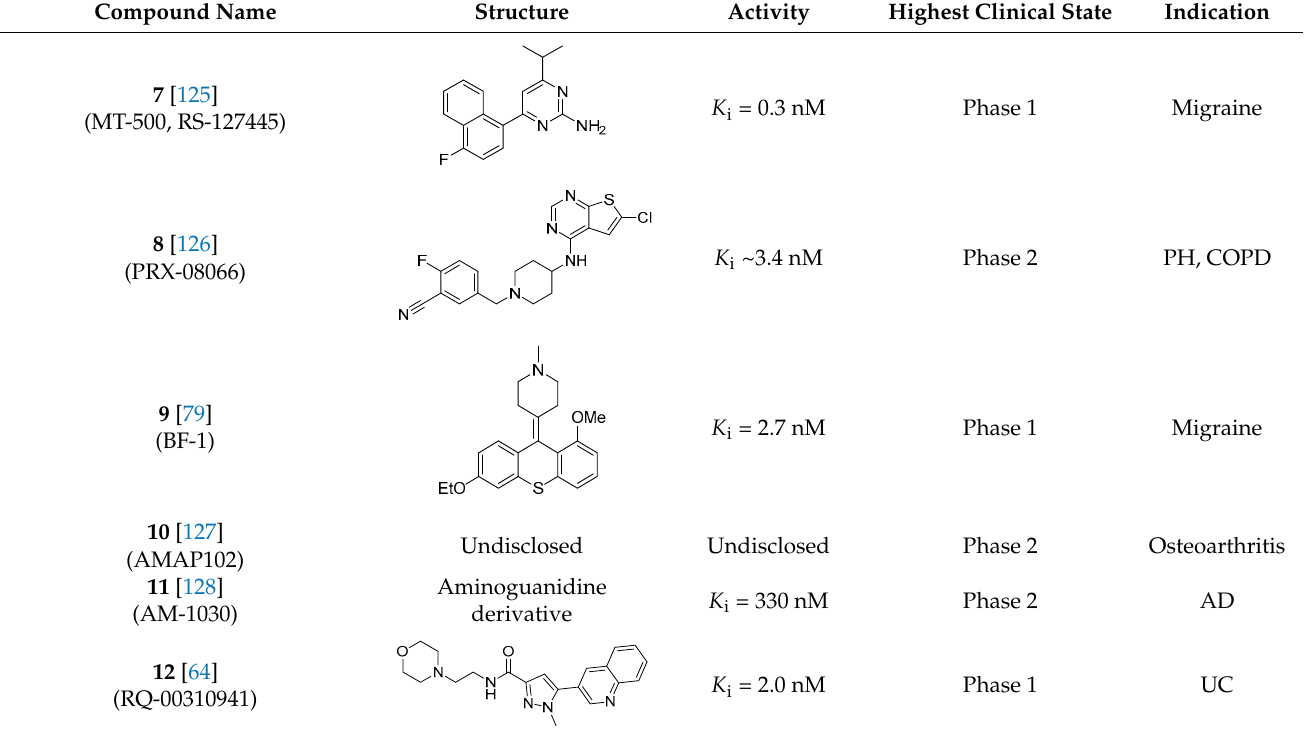
Table 2. 5-HT 2B R antagonists once came into clinical trials or are in clinical trials.